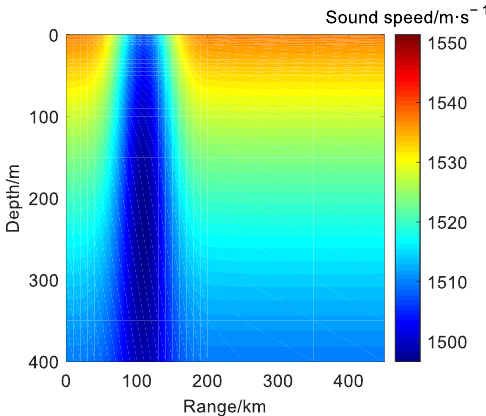
Figure 5. Sound speed profile of Gaussian eddy.